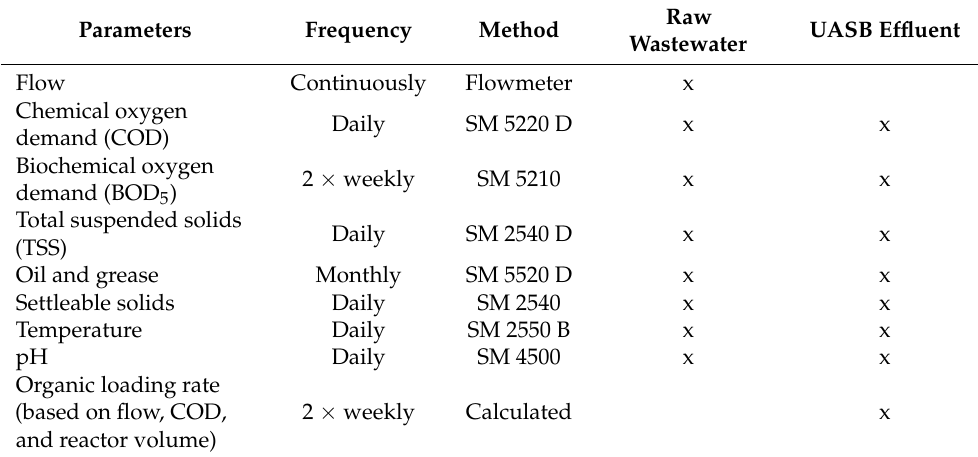
Table 2. Parameters and operation variables measured in the raw wastewater and UASB